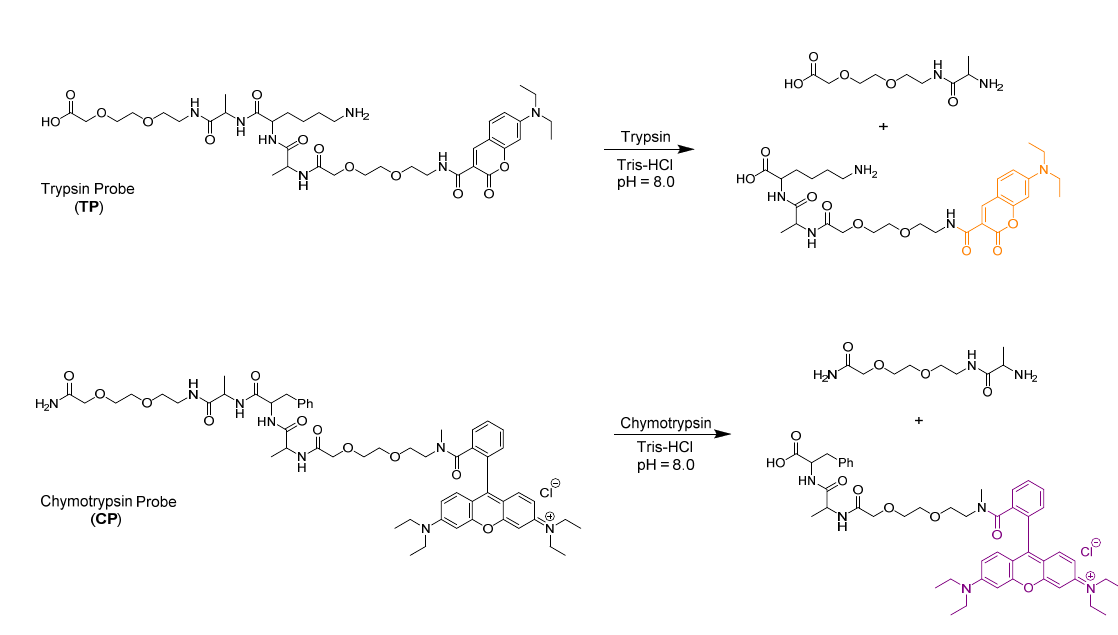
Figure 2. On-resin ( A ) and in-solution ( B ) enzymatic cleavage.